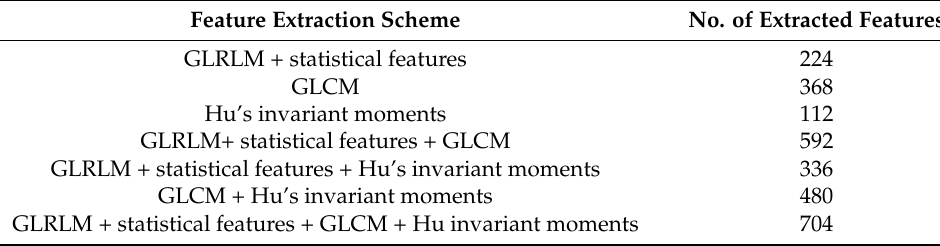
Table 2. Number of features extracted using various feature extraction schemes. Feature Extraction